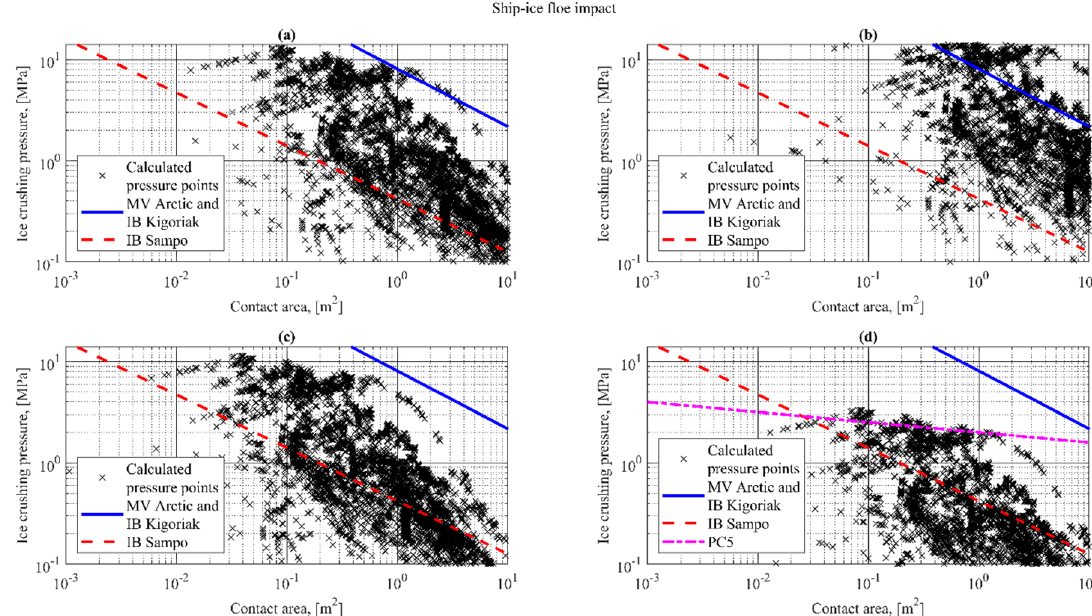
Figure 10. Measured vs. calculated ice crushing pressure-area relationships. Collison type: Ship–ice floe impact. Contact geometries: ( a ) Right-apex oblique; ( b ) Round; ( c ) Symmetric v wedge; ( d ) Angular. The ice crushing pressure-area relationships determined based on measurements conducted on MV Arctic and IB Kigoriak, and on IB Sampo, were determined based on Kujala